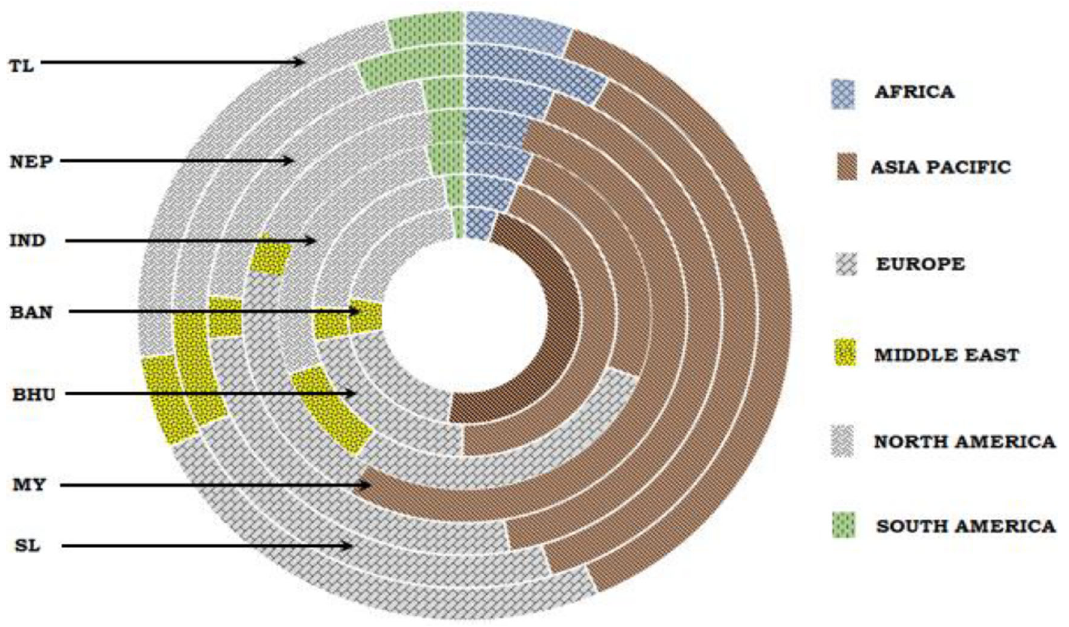
Figure 8.Share of internationalcollaborative publicationof BIMSTEC. India(IND), Thailand(TL),Bangladesh (BAN), Sri Lanka (SL), Nepal (NEP), Myanmar (MY), Bhutan (BHU).